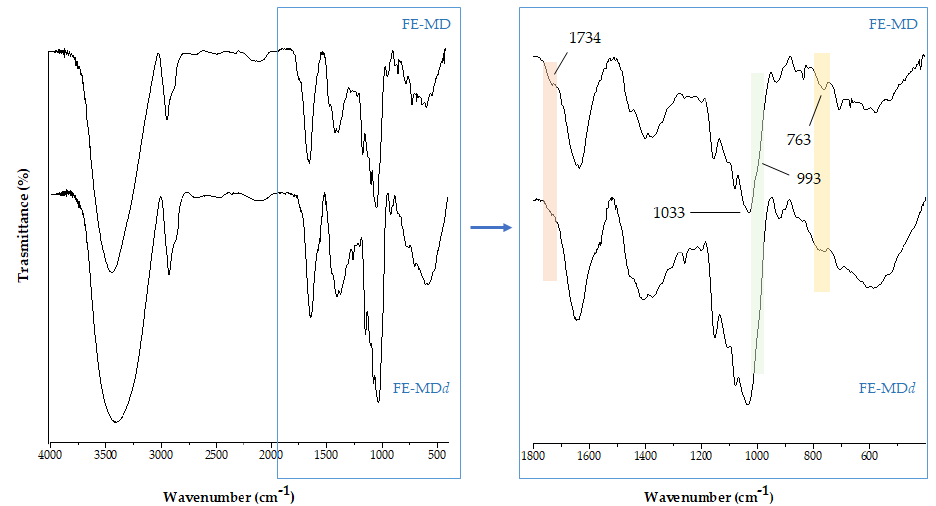
Figure 4. The comparison of FTIR spectra of floret encapsulate before (FE-MD) and after in vitro digestion (FE-MDd).